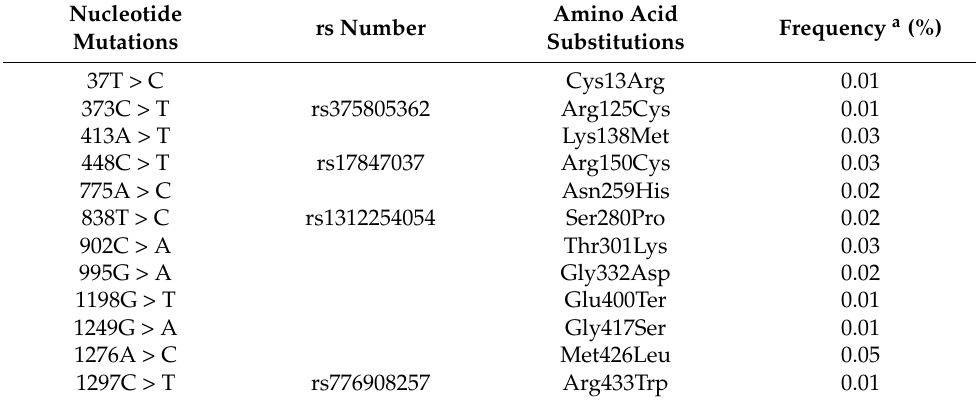
Table 1. Novel CYP2C9 allelic variants characterized in this